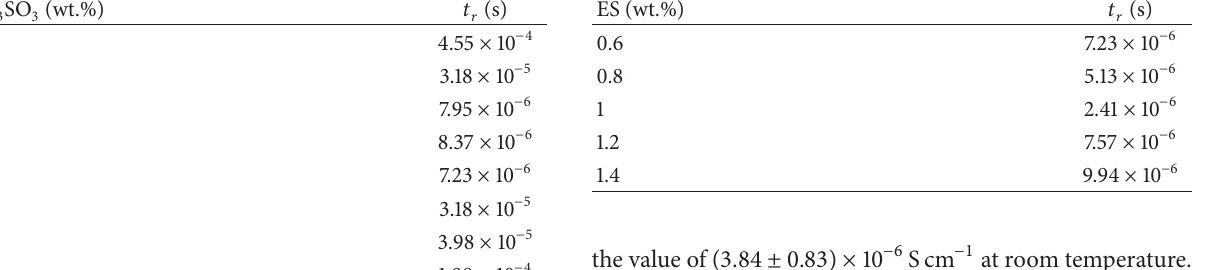
Table 1: Relaxation time ( 𝑡 𝑟 ) for PEO-GO-LiCF LiCF SO (wt.%) 3 3